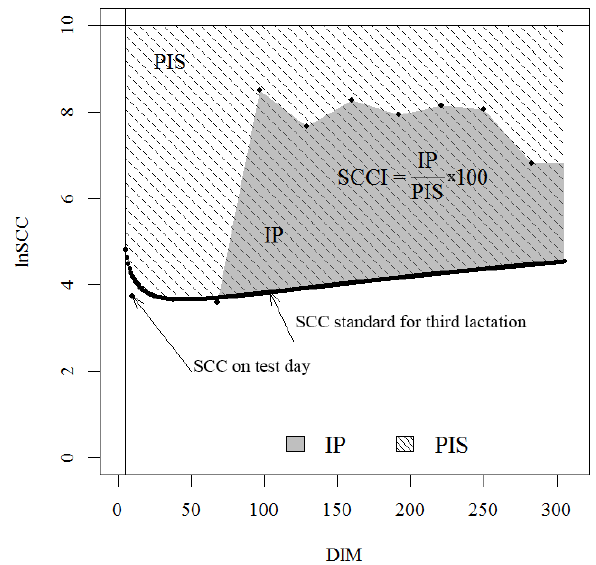
Figure 1. SCCI of a cow in the third lactation with somatic cell count (SCC) values on test days in relation to the standard shape of the curve for SCC. Jeretina et al.